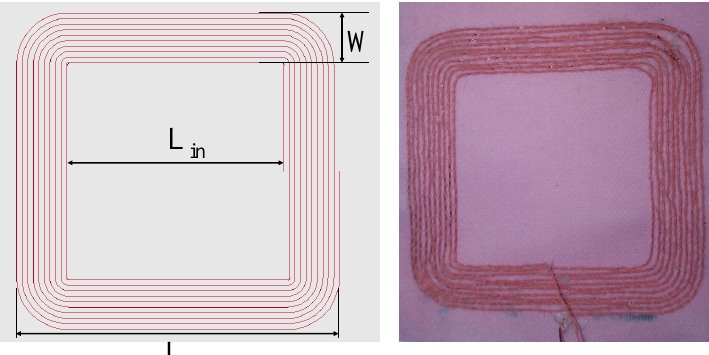
Figure 4. Layout and photograph of the fabricated textile coil. Dimensions (in mm): L = 60, L in = 40, W = 10.